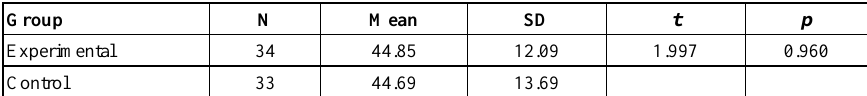
Table 1. The pre-test of